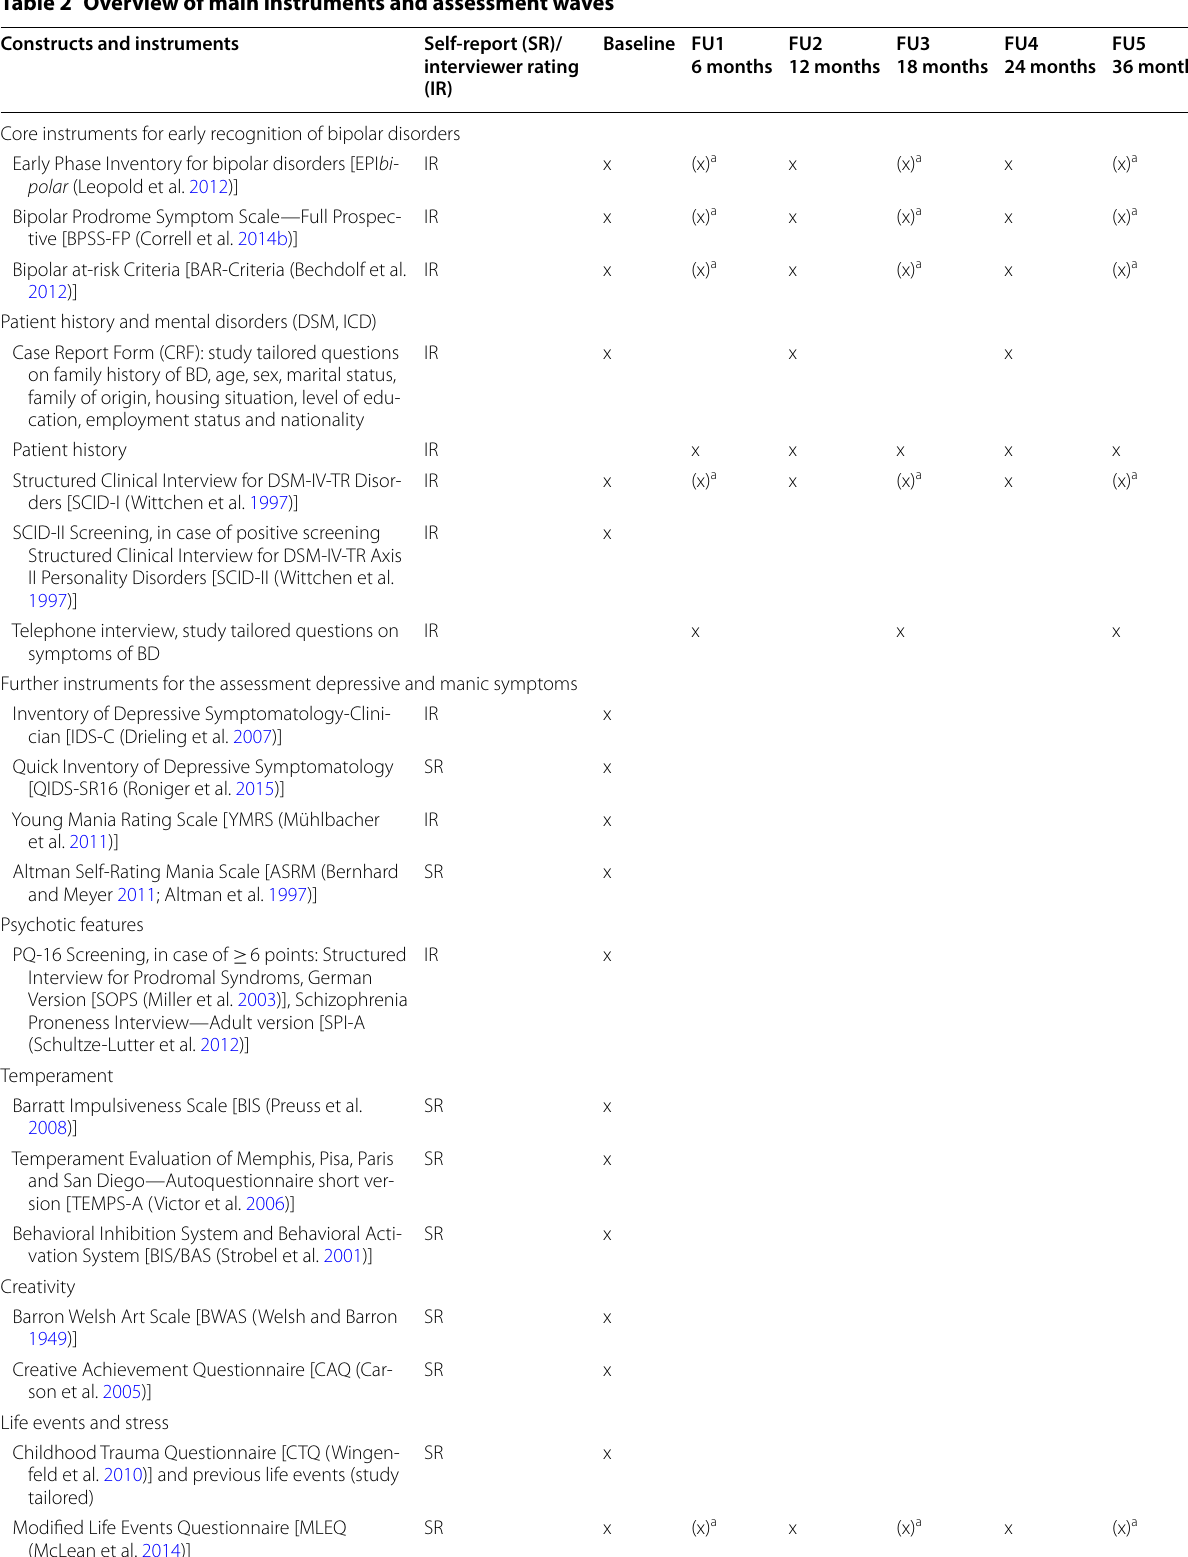
Table 2 Overview of main instruments and assessment